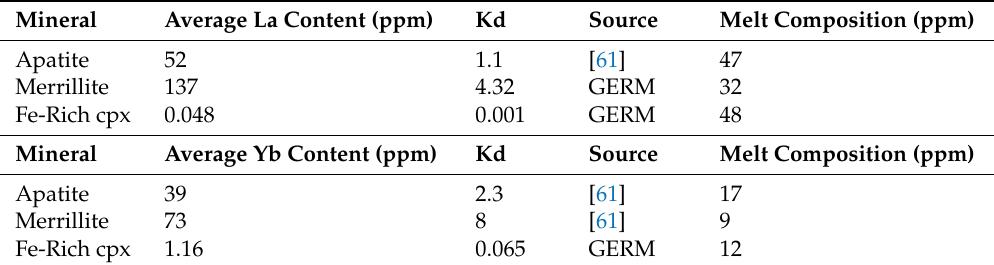
Table 2. Melt composition recalculated on the basis of a trace element concentration in apatite, merrillite and